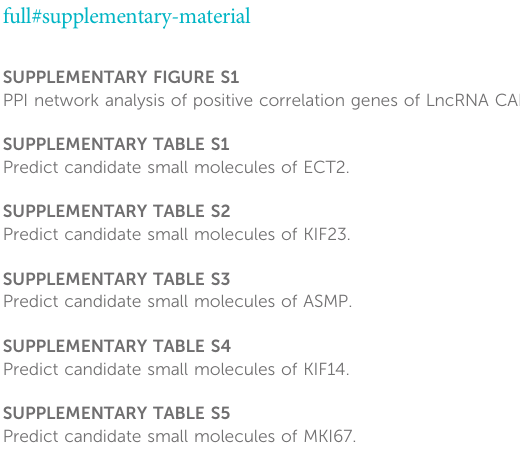
PPI network analysis of positive correlation genes of LncRNA CAHM.